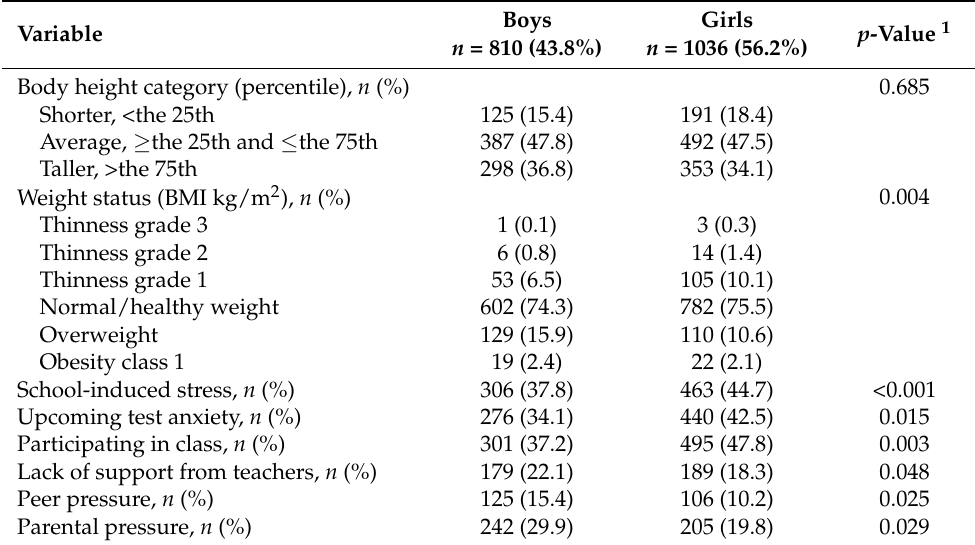
1 Gender differences: p -values represent results of independent samples Student’s t -test for continuous variables and Pearson’s chi-square test for categorical